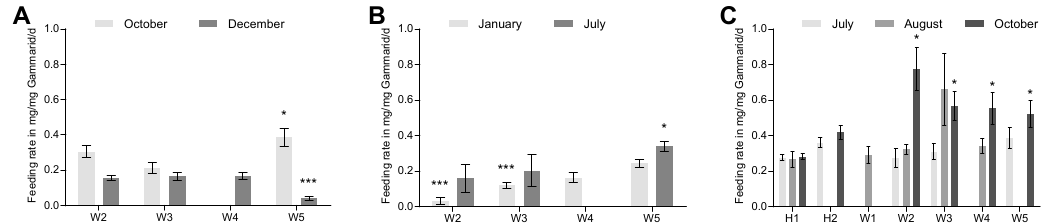
Figure 2. Feeding rates for the seven independent experiments conducted in 2015 ( A ), 2016 ( B ), and 2017 ( C ). The bars in ( A – C ) show the mean feeding rate calculated for each period at the respective sampling site, while the error bars depict the standard error of mean (SEM) of each measurement. The sampling sites were compared to each other using the Bonferroni correction (*** p < 0.001) for one-way ANOVA; otherwise, ANOVA on ranks was used (* p < 0.05). See raw data in Supplementary Materials, Tables S1–S4.